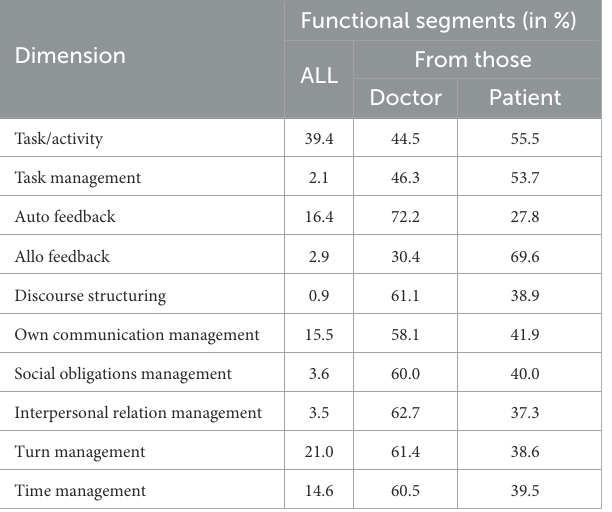
TABLE 2 Distribution of functional segments across dimensions produced by the doctor and the patient, in terms of relative frequency (in %).